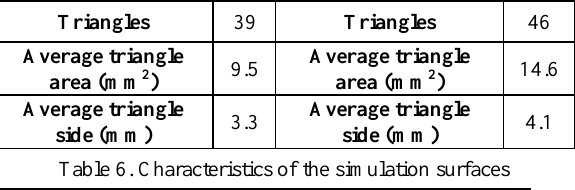
Figure 4: The first pair of surfaces, with 50 points and 78 triangles each.